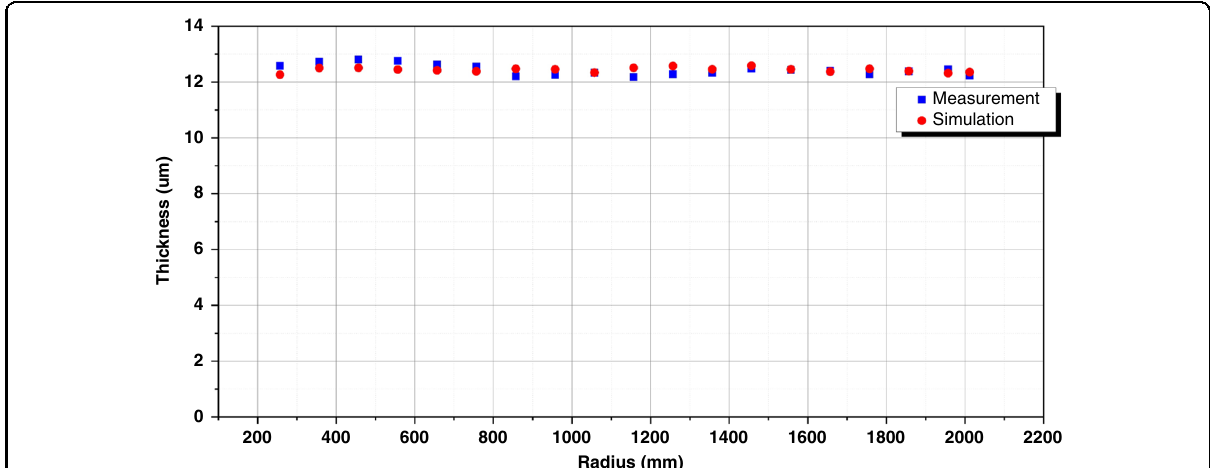
Fig. 10 Comparison of the simulated and actual deposition thickness of the cladding layer. The measured thickness inhomogeneity of Si cladding layer is